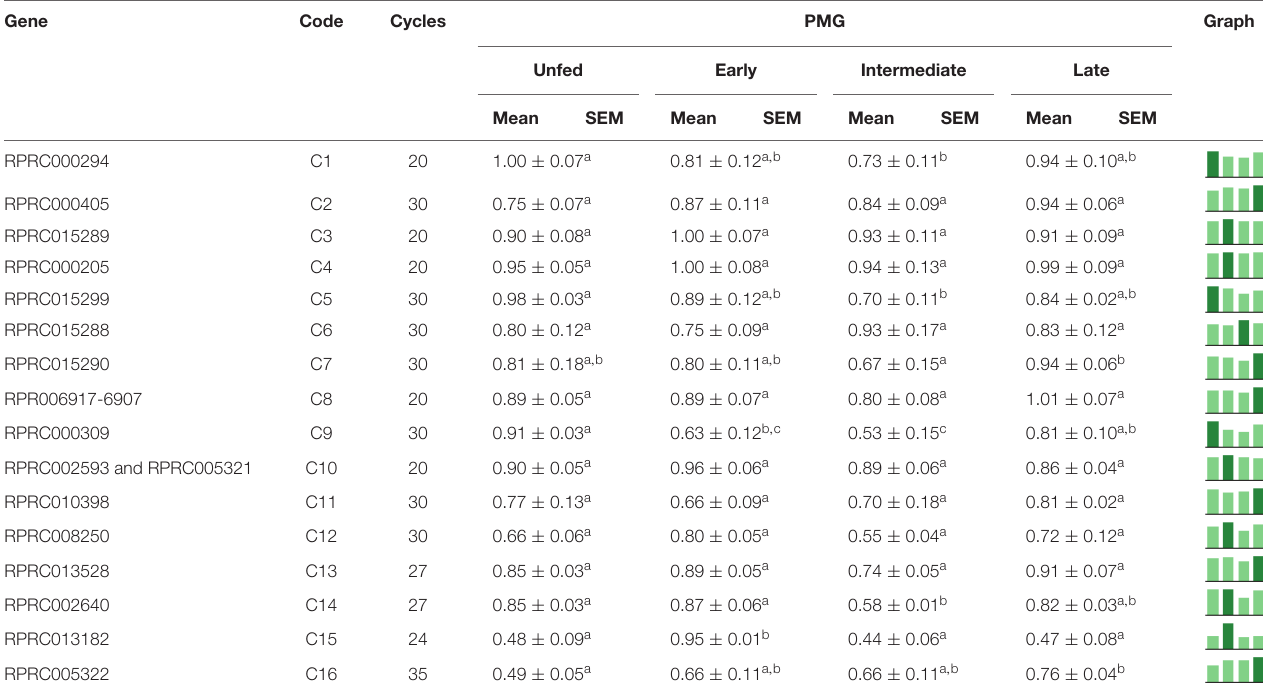
Figures are means ± SEM from three amplification determinations using cDNA pool preparations of six insect samples each. In a dataset, groups with the same superscript letter are not significantly different (p ≥ 0.05). In the miniature graphs, differently colored bars highlight the highest expression levels. Statistical analysis consisted of ordinary two-way ANOVA with Tukey’s multiple-comparisons